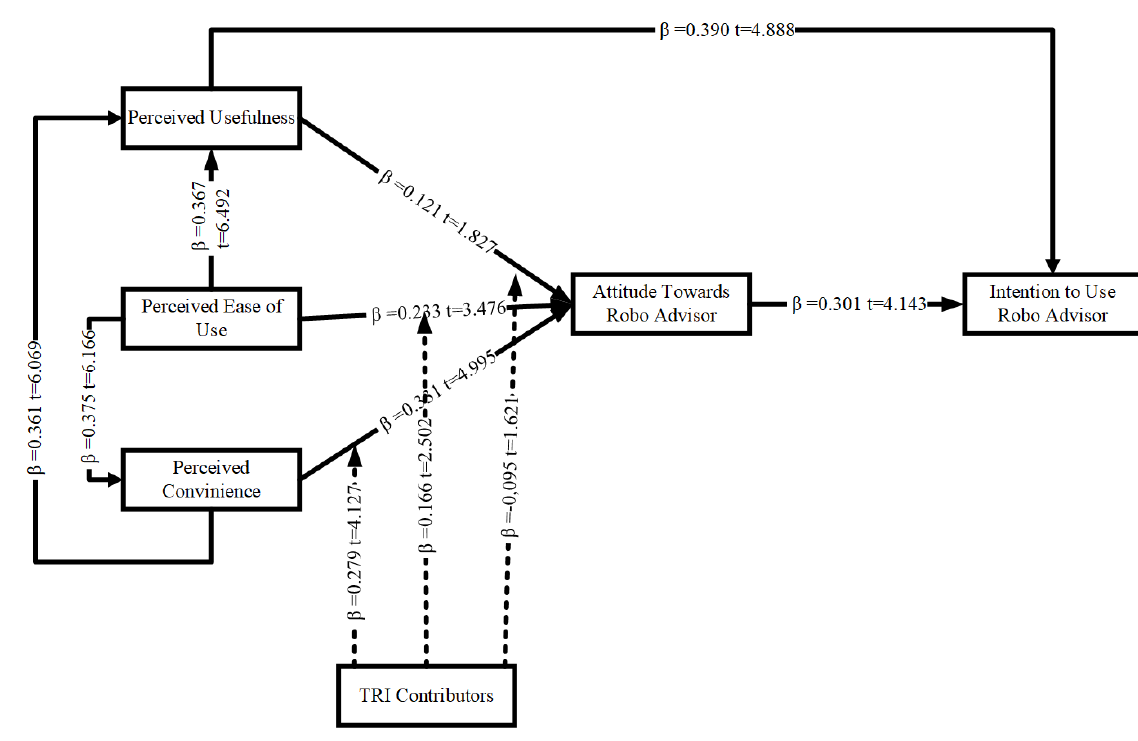
Figure A2. Base Line Structural Model.